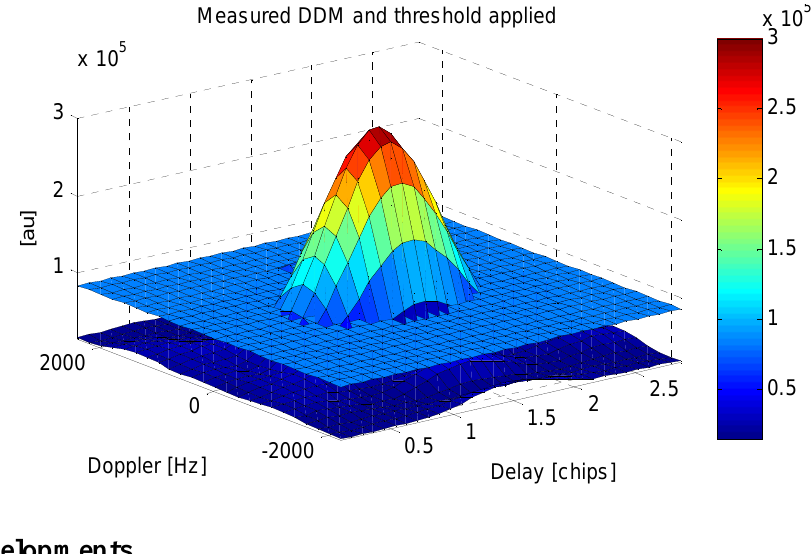
Figure 4. Measured (not normalized) 1 s incoherently integrated DDM with the threshold applied to compute its volume. Noise is well below the threshold